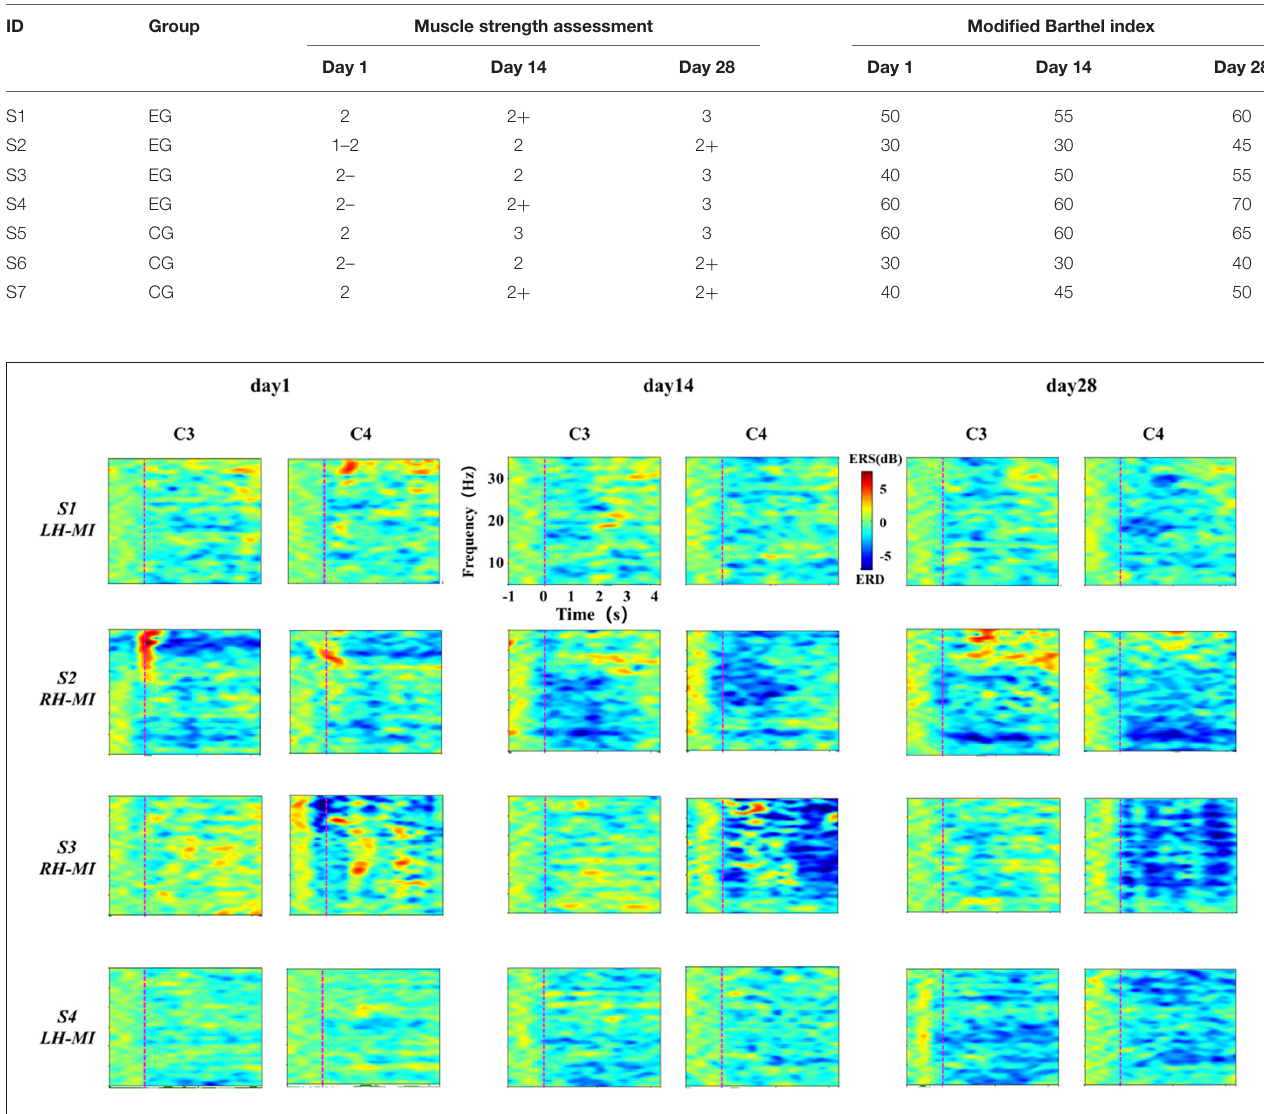
FIGURE 5 | Results of EEG time-frequency response under standard assessment session in experimental group during long-term rehabilitation